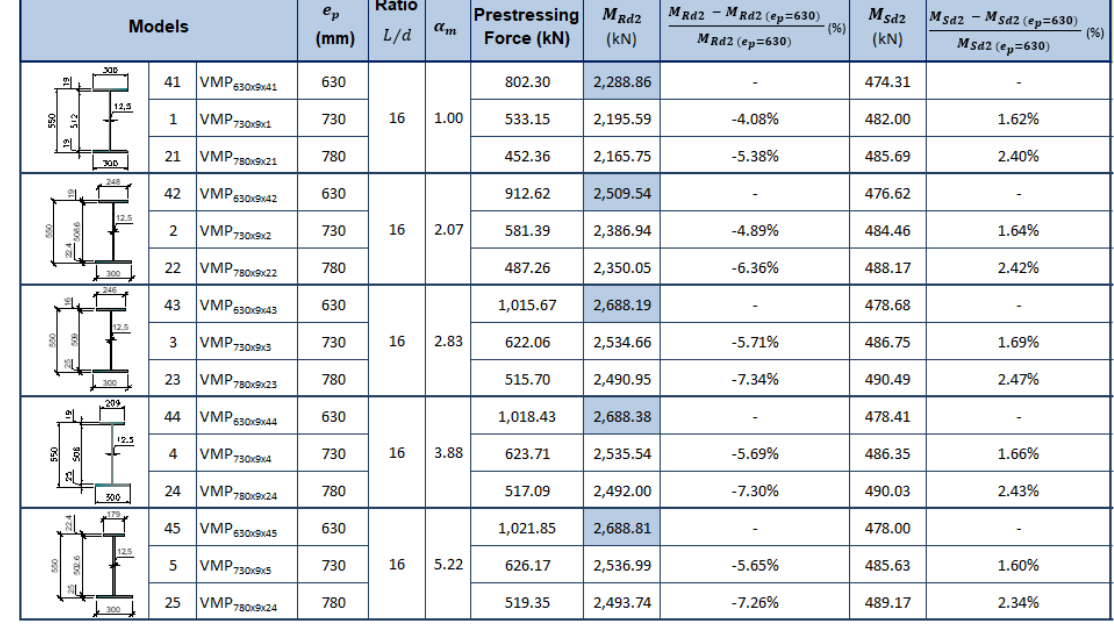
Figure 9. Eccentricity influence - / L d ratio =